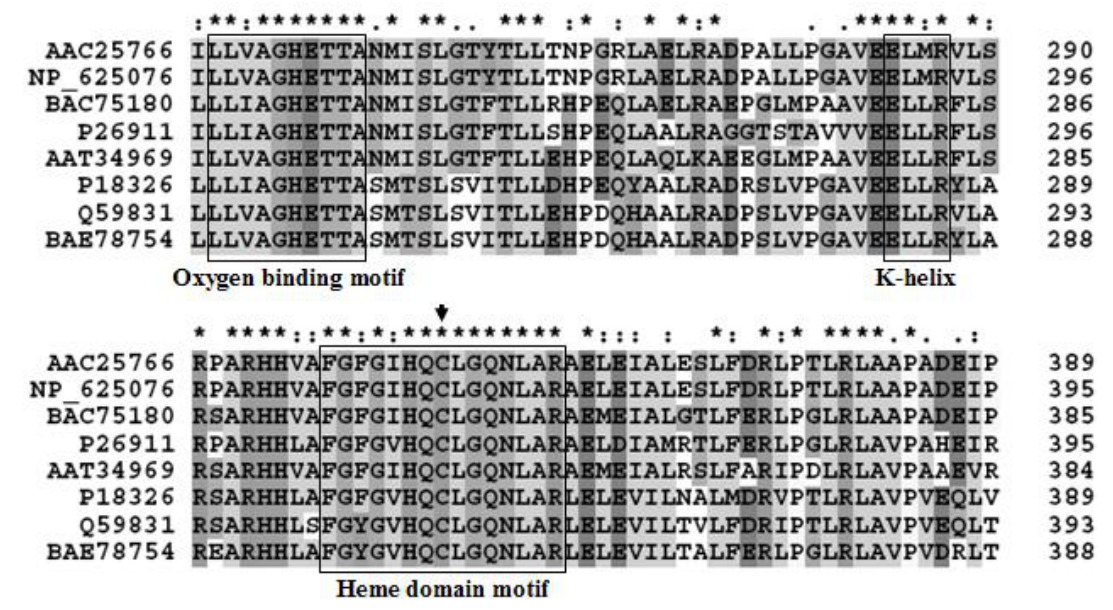
Figure 1. Cytochrome P450 alignments of the amino acid sequence with other bacterial strains. P26911; CYP from Streptomyces griseus , BAC75180; CYP from Streptomyces avermitilis MA4680, AAC25766; CYP from Streptomyces lividans , NP_625076; CYP from Streptomyces coelicolor A3(2), AAT34969; CYP from Streptomyces tubercidicus , P18326; CYP from Streptomyces griseolus , BAE78754; CYP from Streptomyces sp . TM-7, Q59831; CYP from Streptomyces carbophilus . Multiple sequence alignment of conserved motifs in P450 enzymes identified. Both oxygen-binding motif and heme domain sequences as well as the EXXR motif in the K helix are shown. Amino acids conserved in the P450s listed are shown. The Cys residue that coordinates the heme is indicated by an arrow. Alignments were performed with the CLUSTAL X 1.83. ( * ) Identical residues in the different enzymes; (:) conserved substitutions; (.) semi-conserved